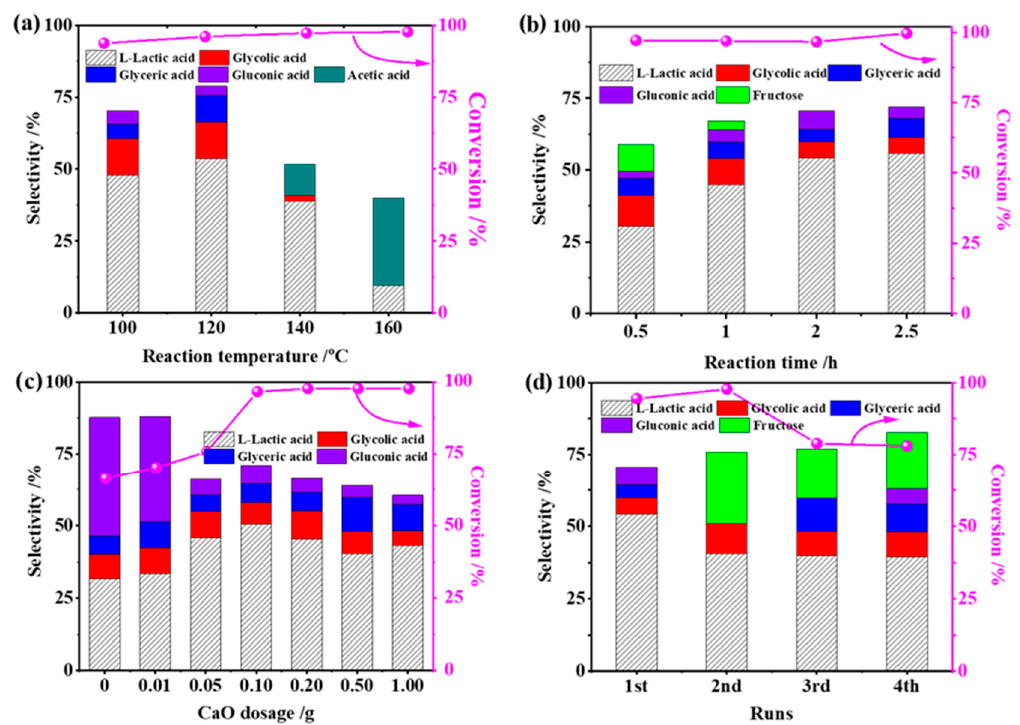
Figure 1. Catalytic conversion of glucose at different ( a ) reaction temperatures, ( b ) reaction times, ( c ) amounts of CaO and ( d ) stabilities of catalysts (typical reaction conditions: 20 mL 1% glucose, 0.10 g catalyst, 120 °C, 1.0 MPa O 2 , 2 h. One condition was altered while other factors were kept the same in each case).